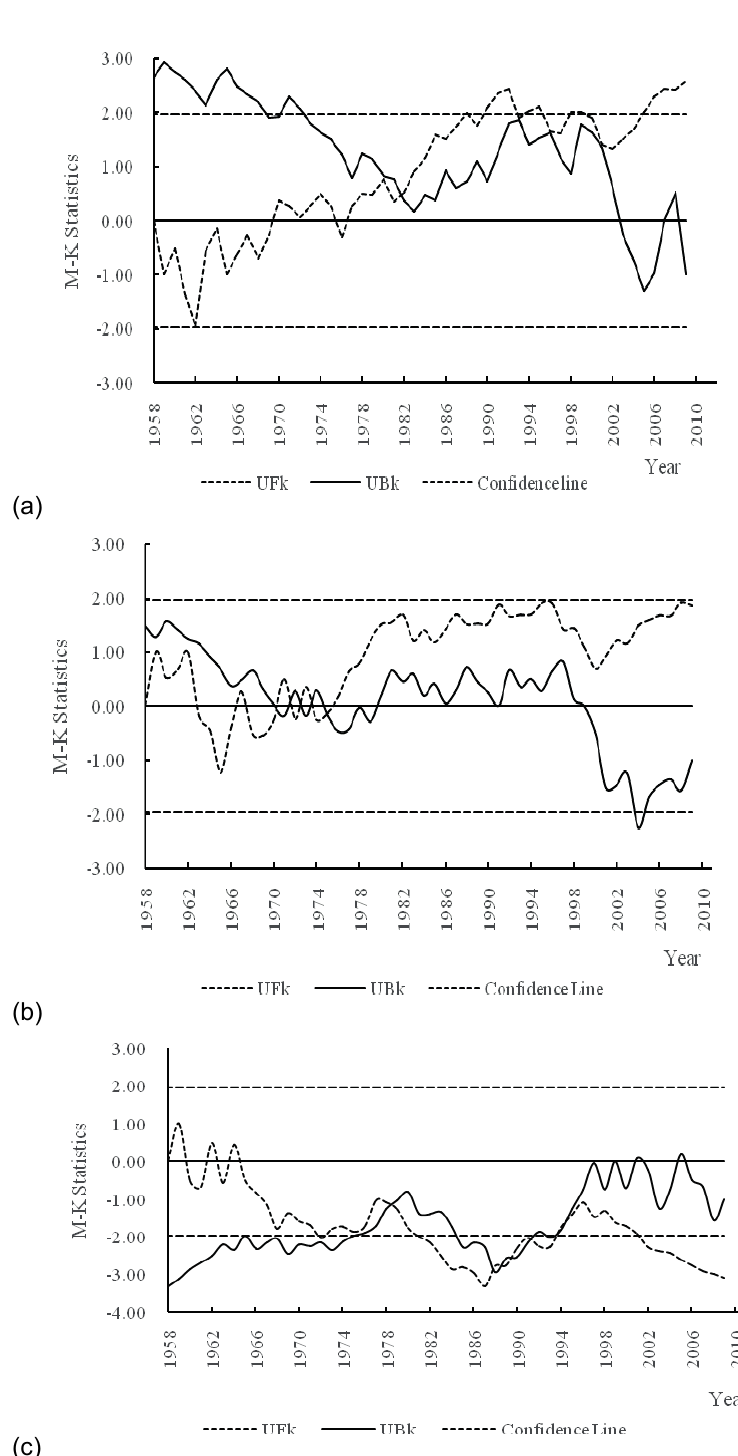
Fig. 4 M-K curve of precipitation in: (a) May, (b) June, and (c)